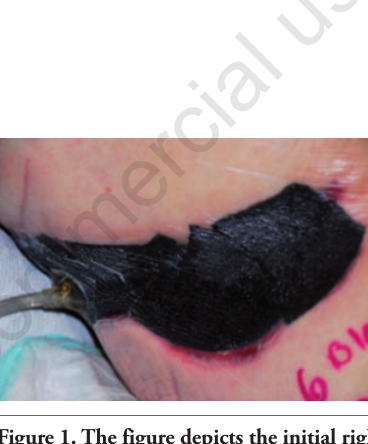
Figure 1. The figure depicts the initial right flank lesion after wound VAC placement.